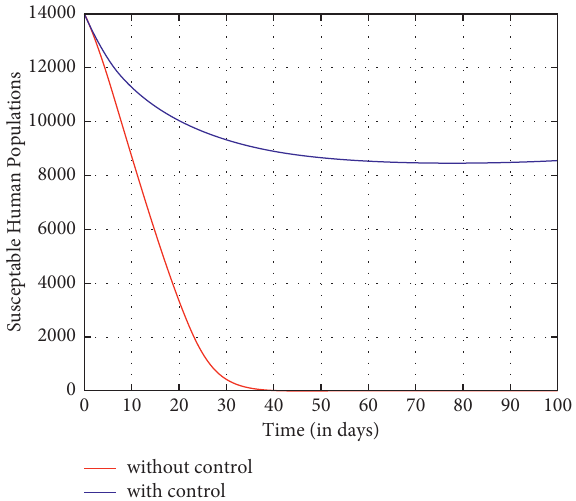
Figure 17: Susceptible human population with and without control variable u